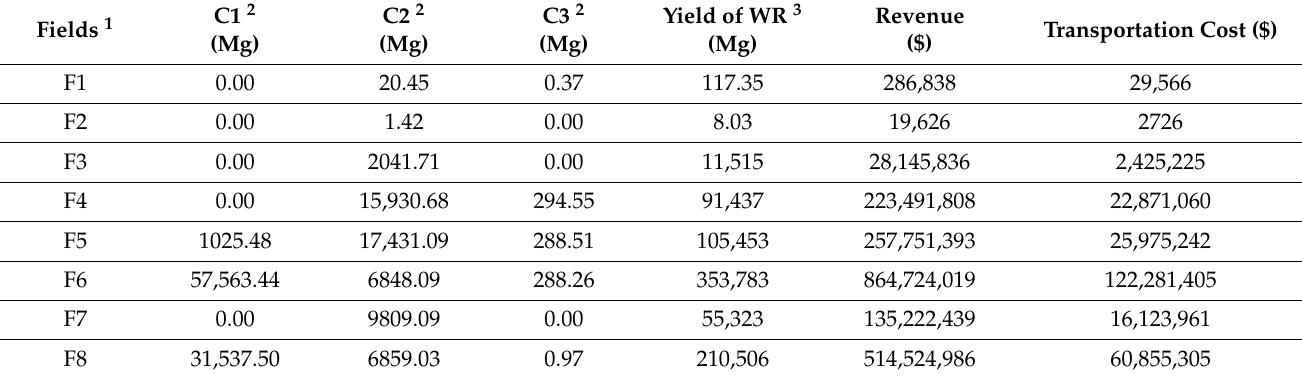
Table 10. Analysis of the optimized locations of rice paddy